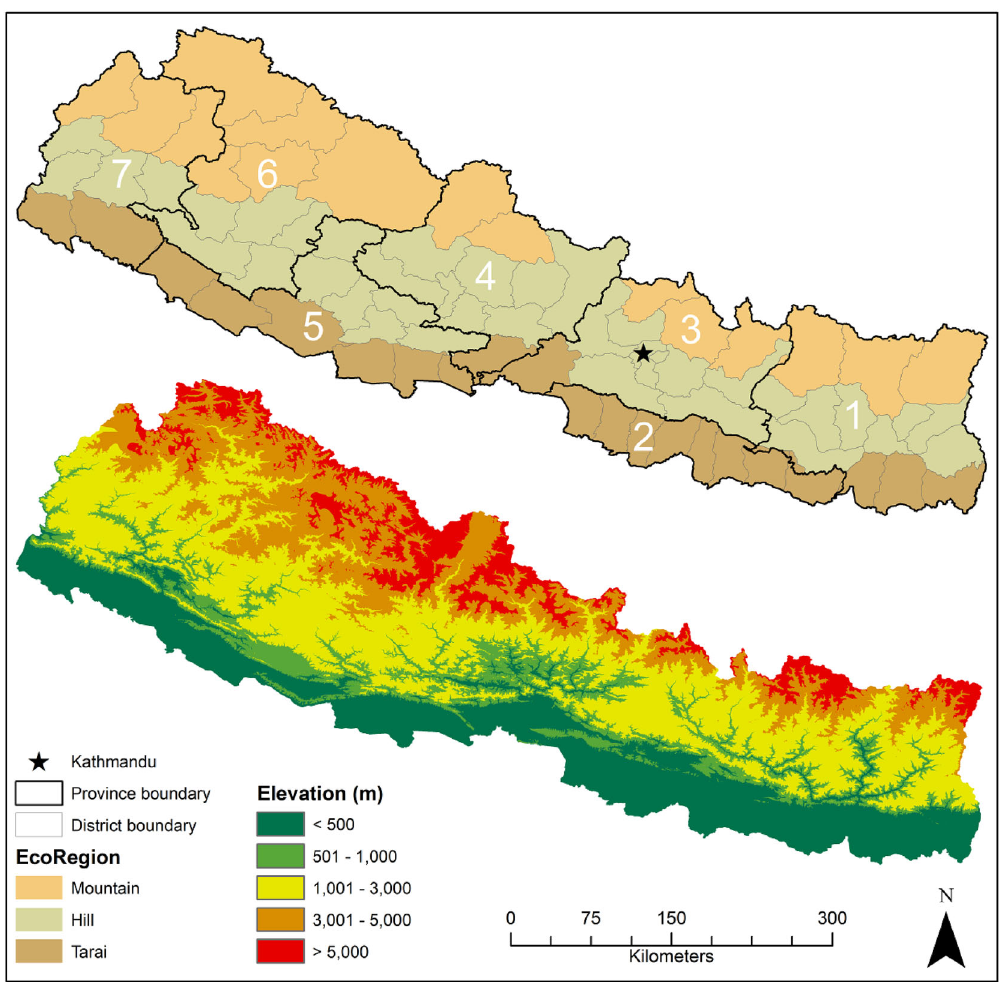
Fig. 1 Physical and administrative map of Nepal. The numbers 1–7, as indicated on the map, are the provinces created in 2015 that have yet to be named by the